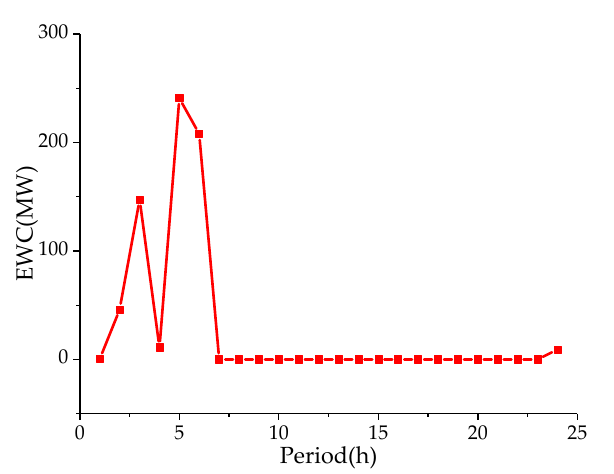
Figure 4. Expected wind power curtailment in each period in the L3-SUC.